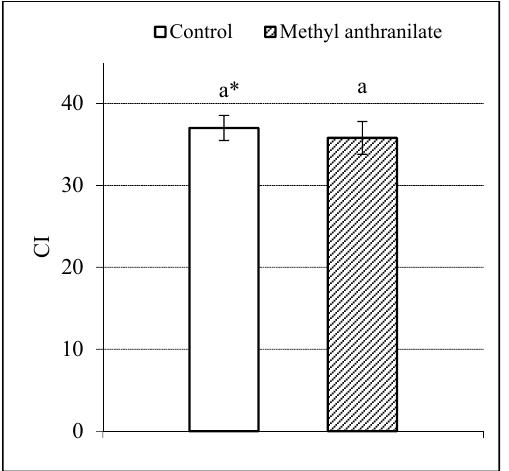
Figure 1. Influence of methyl anthranilate on cracking indices (CI) of fruit of sweet cherry cv. ‘Burlat’; * Data are presented as mean ± SD. Means assigned identical letters do not differ significantly at the level of significance p = 0.05.